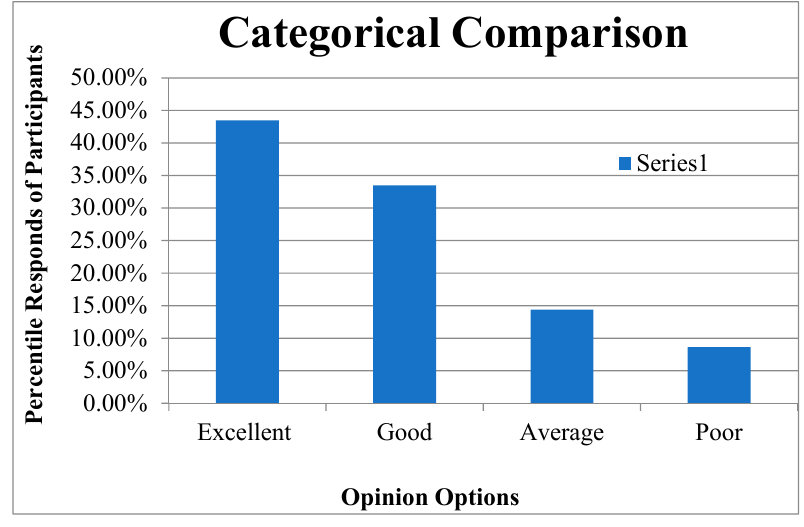
Figure 6. Categorical comparison graph.